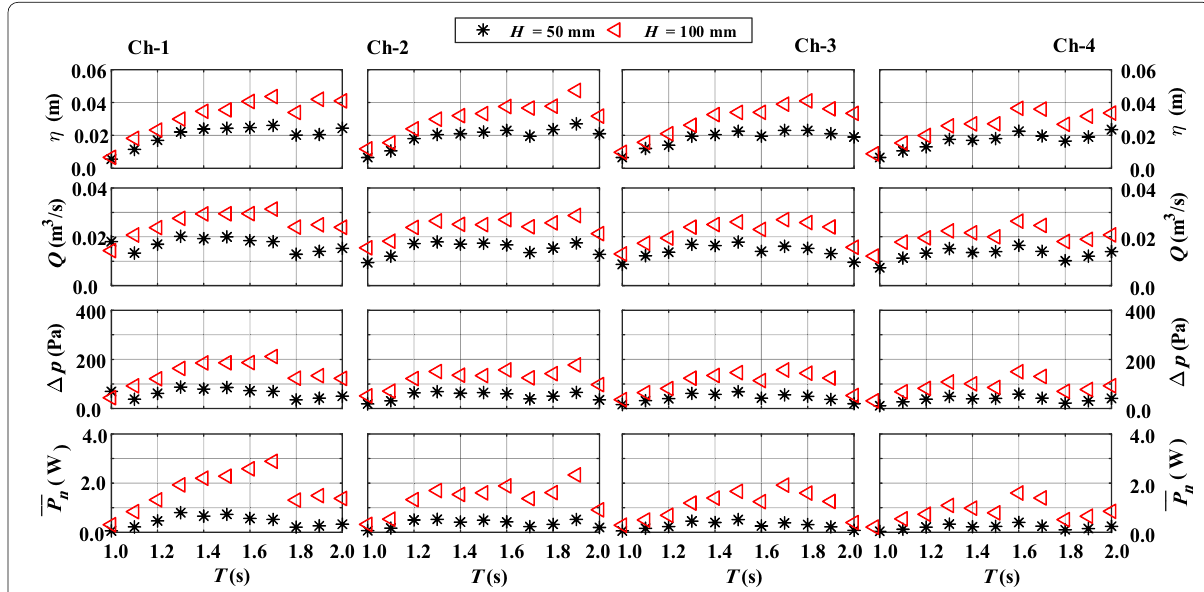
Figure 6 Effect of wave height on water surface elevation η (1st row), airflow rate Q (2nd row), differential air pressure ∆ p (3rd row), and pneumatic power P n (4th row) for different wave periods under a constant orifice opening ratio R 2